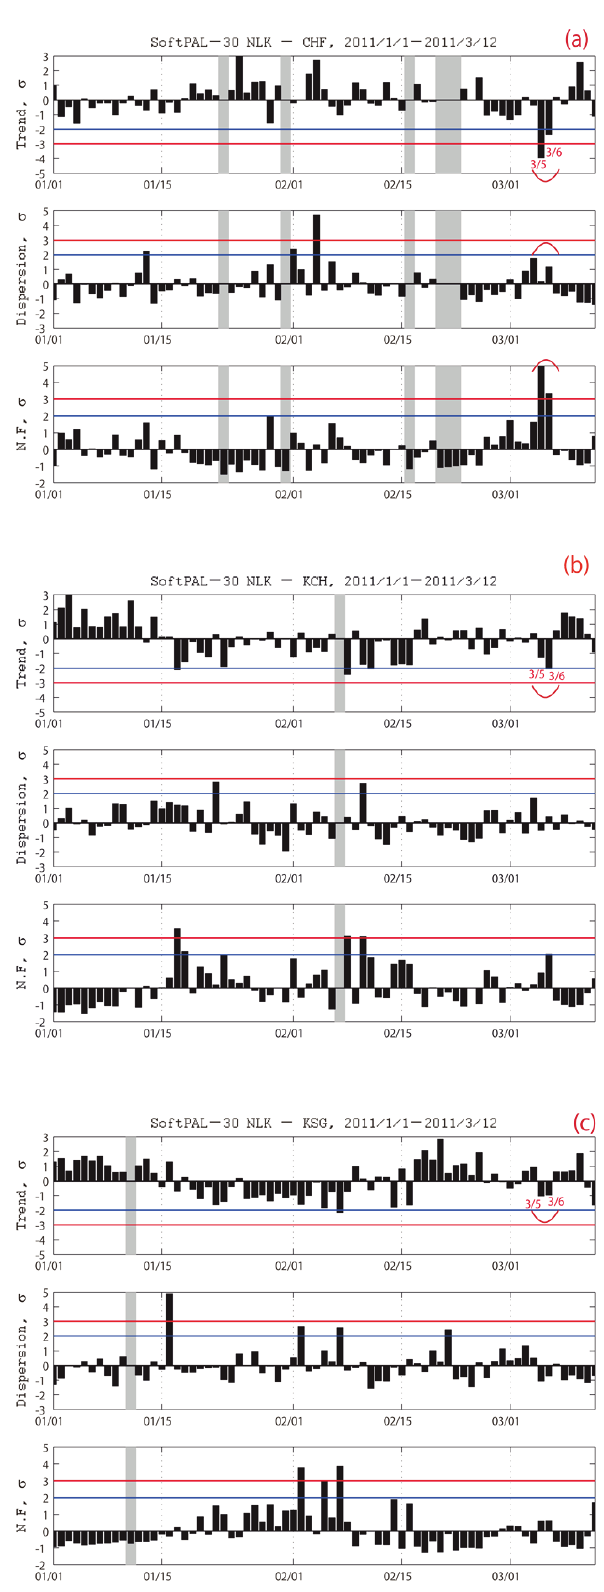
Figure 3. Temporal evolution of the propagation characteristics for the three propagation paths: (a) NLK–CHF; (b) NLK–KCH; and (c) NLK–KSG. The period from January 1 to March 12, 2011, is shown. Pay attention to the period from March 1 to March 12, to define any precursor to the March 11, 2011, earthquake. (a, b, c) Top: trend (average night-time amplitude). Middle: dispersion (as a measure of the amplitude fluctuation). Bottom: night-time fluctuation, as defined by the night-time integration of the area of dA(t)<0. Any significant anomaly should be indicated in (a), (b) and